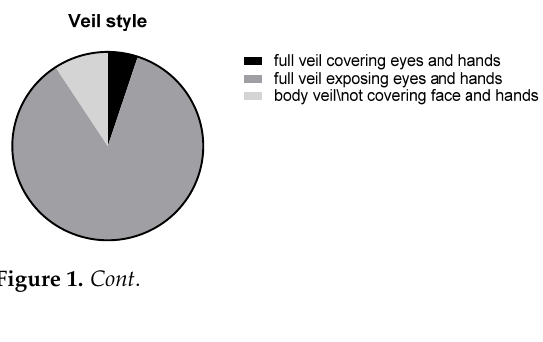
Figure 1. Veil style, duration, and time of sun exposure for all participants. 3.3. Biochemical Measurements To assess the health status of the participants, the baseline levels of lipid profile, Mg, P, PTH, albumin, CRP, and creatinine were measured at the beginning of the study. After 3 months of vitamin D supplementation with a low or high dose, the serum levels of these markers were measured again (Table 2). The results showed that they were all within nor- mal levels and no significant change was observed after vitamin D supplementation, ex- cept for high-sensitivity CRP, which was significantly decreased in both the LDVD and HDVD groups. Table 2. Biochemical measurements. LDVD-B